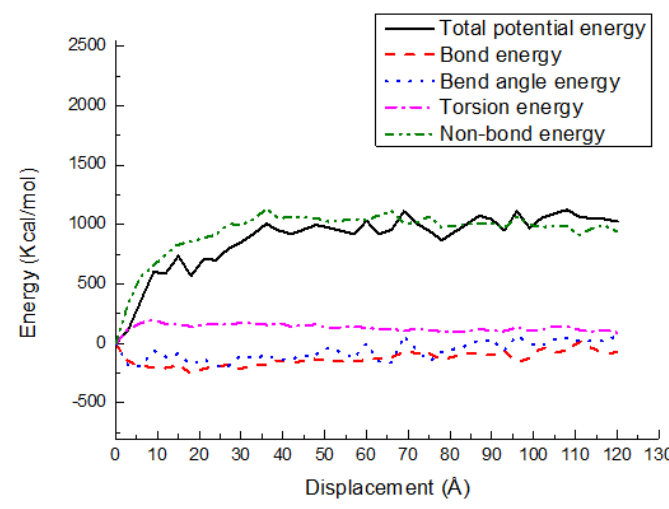
Figure 17. Potential energy-displacement curves for the PE(76 – 40)/S interface in the shear case.